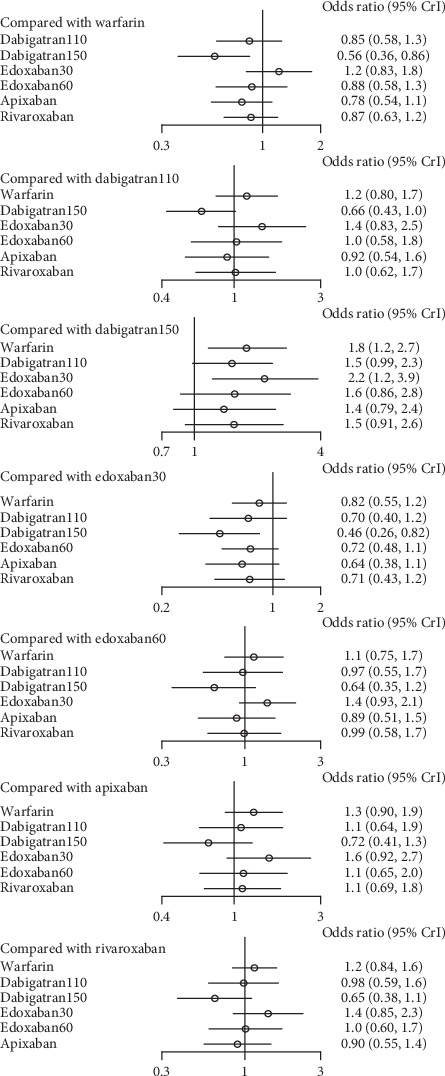
Forest plot for the efficacy of the comparison among different treatments of patients with moderate renal function.